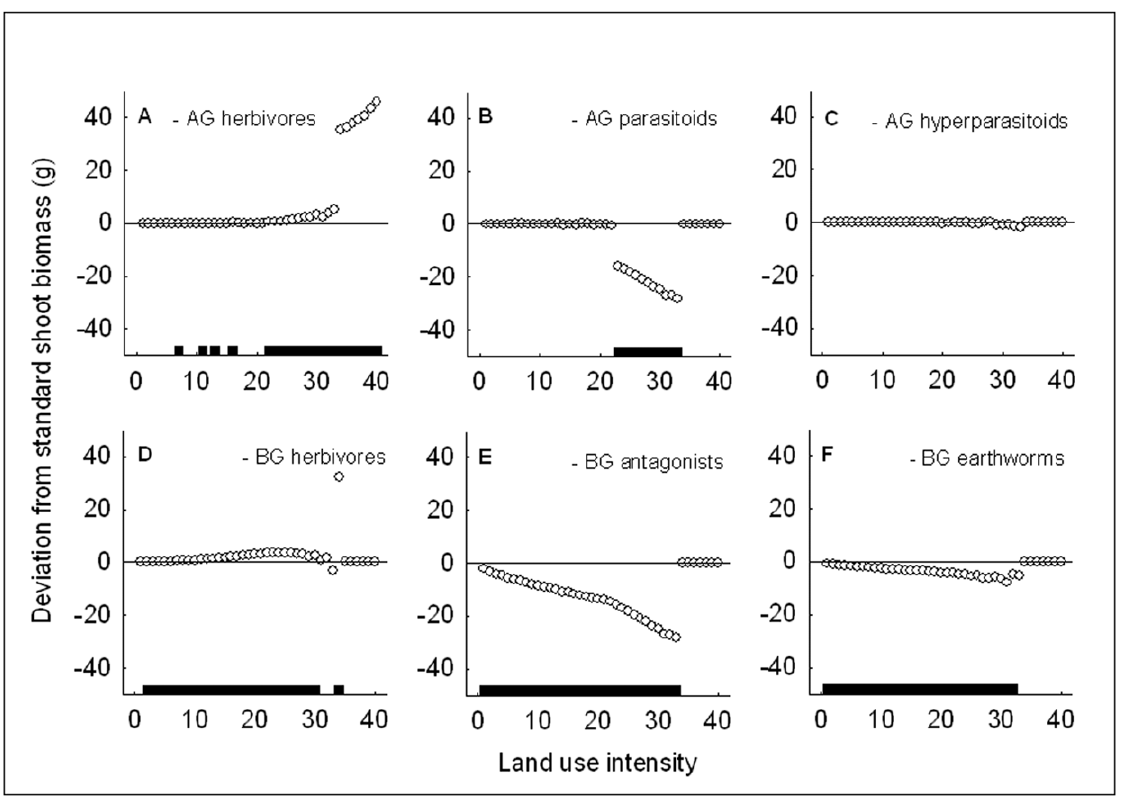
Figure 4. Shoot biomass and multitrophic interactions with increasing land use intensity. Deviation from median shoot biomass in the standard scenario from low to high land use intensity after removal of aboveground (top row) and belowground (bottom row) trophic levels and earthworms, i.e. removal of aboveground (a) herbivores, (b) parasitoids, or (c) hyperparasitoids, or belowground (d) herbivores, (e) antagonists, or (f) earthworms. AG – aboveground, BG – belowground. The horizontal line at 0.0 represents the values of the standard scenario. Points indicate the difference in shoot biomass between the respective removal scenario and standard scenario, and horizontal bars at the bottom of each graph indicate for each of the 40 points whether this difference is significant based on the Mann-Whitney U -test ( P , 0.05). Points above the 0.0-line show a positive effect of the removal of the respective trophic level on shoot biomass, points below the line a negative one. The horizontal bars show that belowground effects are more important under natural conditions while aboveground effects are stronger towards agroecosystems.